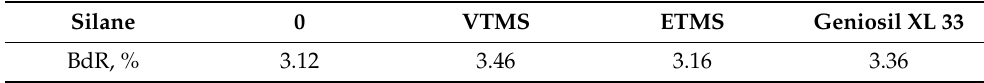
Table 3. Bound rubber content of the EPDM/CaCO 3